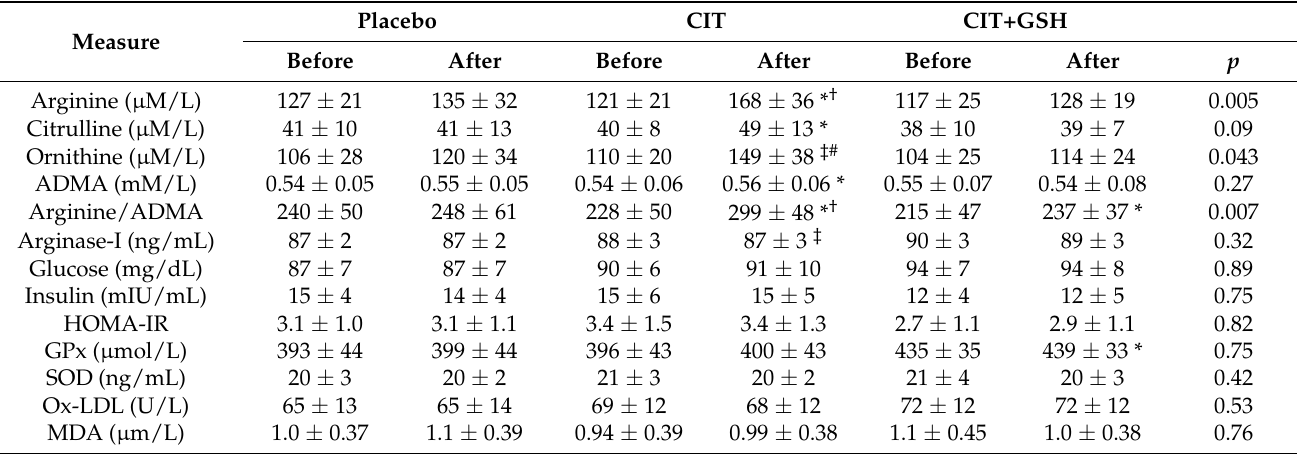
Table 4. Serum markers of arginine metabolism, glucose control, and oxidative stress.